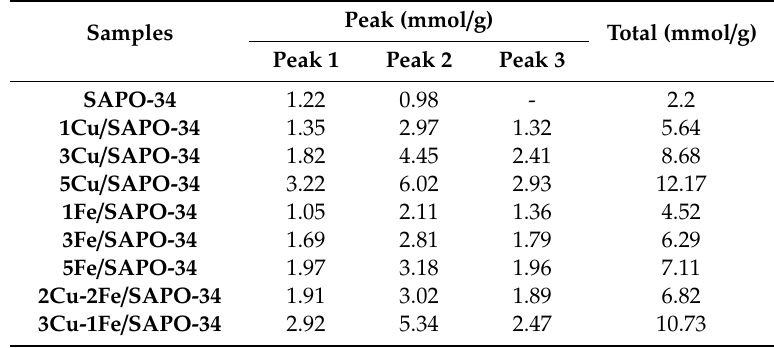
Table 2. Acid properties of the as-synthesized catalyst.